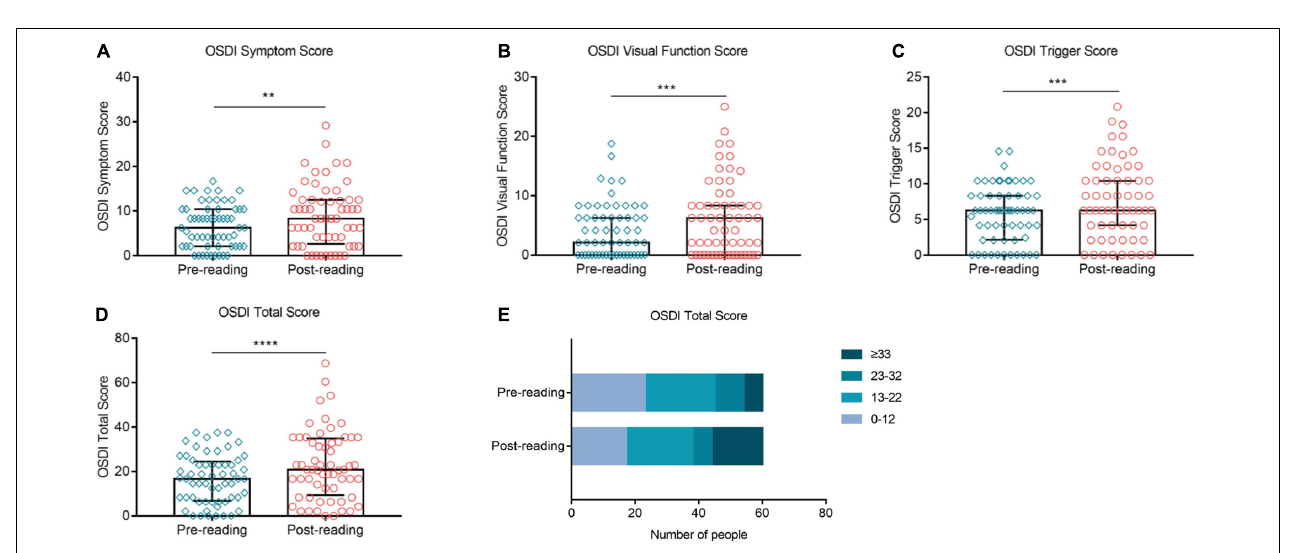
FIGURE 7 | Effects of continuous smartphone reading for 2 h on OSDI, CVS-Q and DEQS. OSDI Symptom score (A) , visual function score (B) , triggers score (C) and total score (D) were increased significantly compared to the baseline level. The proportion of OSDI ≤ 12 decreased significantly, while that of OSDI ≥ 33 increased distinctively during the task (E) . (A–D) Dates are presented as median and interquartile range, ** p ≤ 0.01, *** p ≤ 0.001, **** p ≤